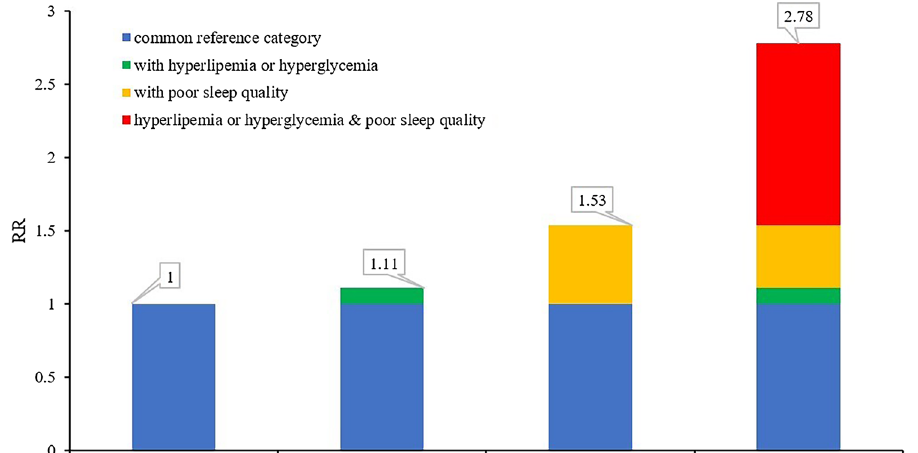
Figure 2. An additive effect of PSQI and hyperlipemia/hyperglycemia for males ≥ 65.